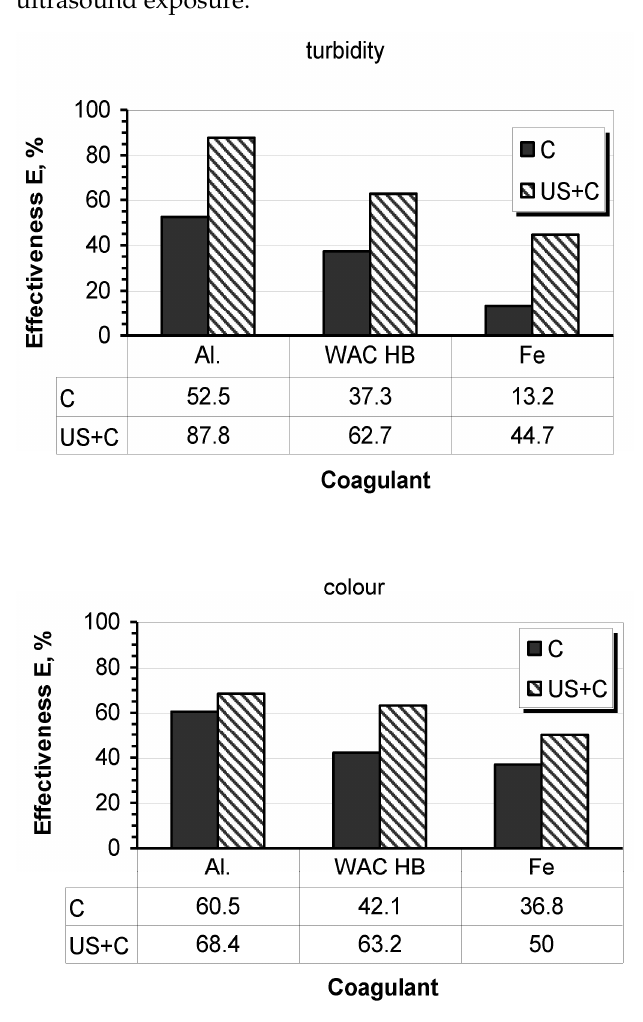
Figure 4. The effectiveness of coagulation in the studied systems aided by ultrasound exposure (8 μ m, 5 min) .